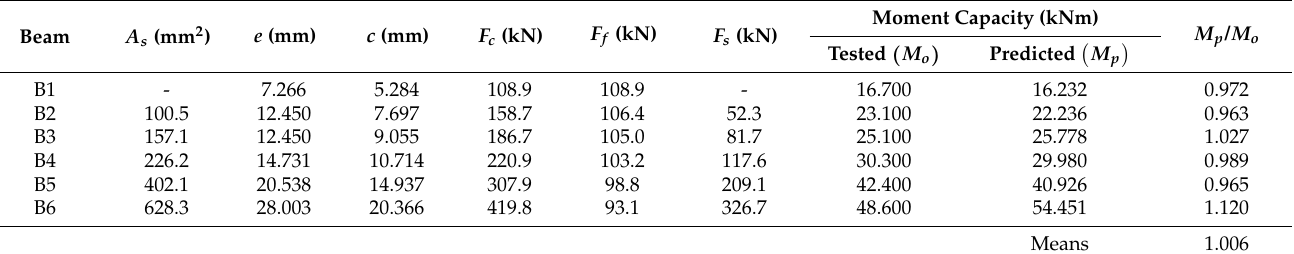
Table 7. Prediction data of the UHPC beams.